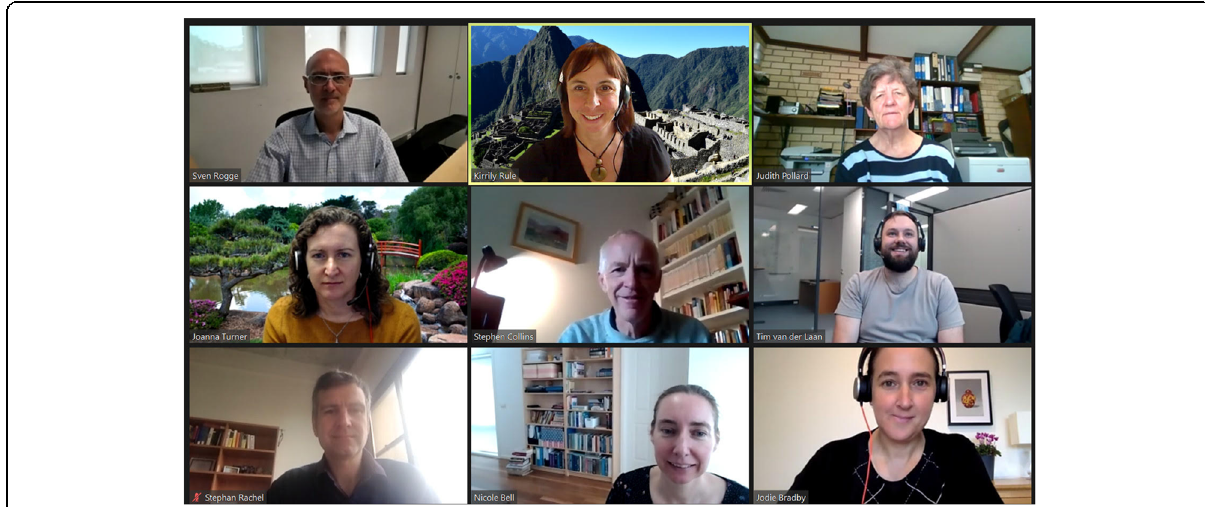
Fig. 7 Some of the new faces of the AIP executive team during a recent Zoom